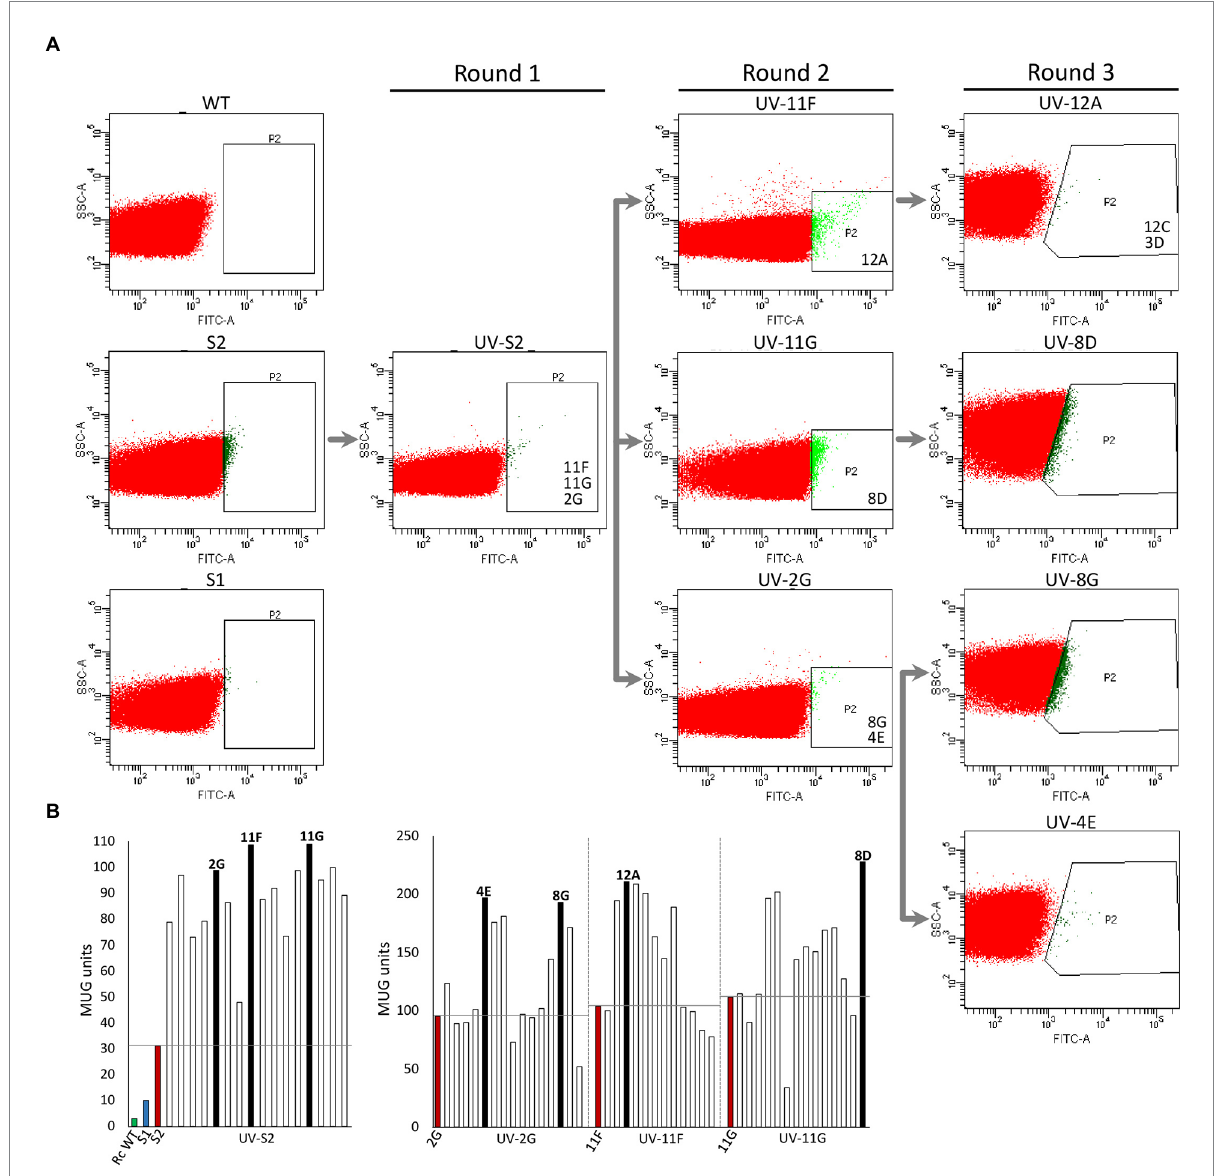
FIGURE 1 High-throughput selection of Rhodobacter capsulatus cells emitting fluorescence in response to H 2 . (A) Fluorescence activated cell sorting. Dot- plot showing side-scattered light (SSC) versus fluorescence generated by fluorescein isothiocyanate (FITC) in R. capsulatus populations of wild type, S1, S2, UV-S2 (pool of S2 cells after UV treatment), and derivative strains obtained by further rounds of UV mutagenesis. P2 indicates areas used for cell sorting into 96-well plates. Strains analyzed in depth in this study ( e. g. 11F, 11G, and 2G) are shown in the P2 area from which they were isolated. (B) Examples of beta-galactosidase activity (MUG hydrolysis in 96-well plate format) of clones sorted by FACS. Left, UV-S2. Right, UV-2G, UV-11F, and UV-11G sorted populations. Green and blue bars show wild-type and S1 and S2 activities, respectively. Red bars show activities of strain subject to each mutagenic treatment. Black bars represent activities of clones selected for further rounds of